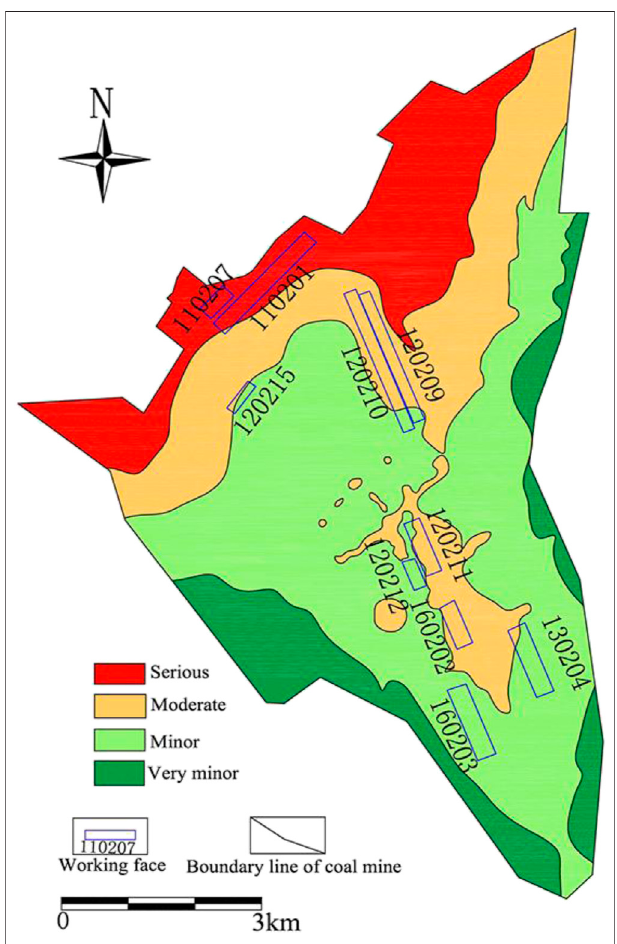
FIGURE 8 | Prediction map of surface damage degree caused by 2 # coal seam mining.